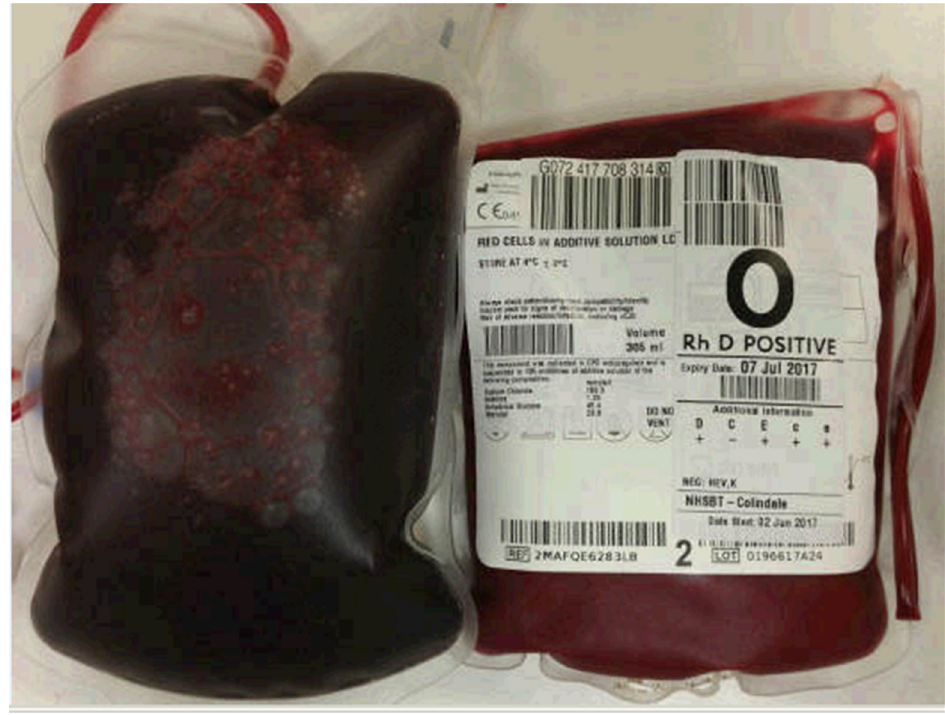
Figure 1. Photograph illustrating the color difference between the patient’s venesected blood (left) and a normal donor unit (right).